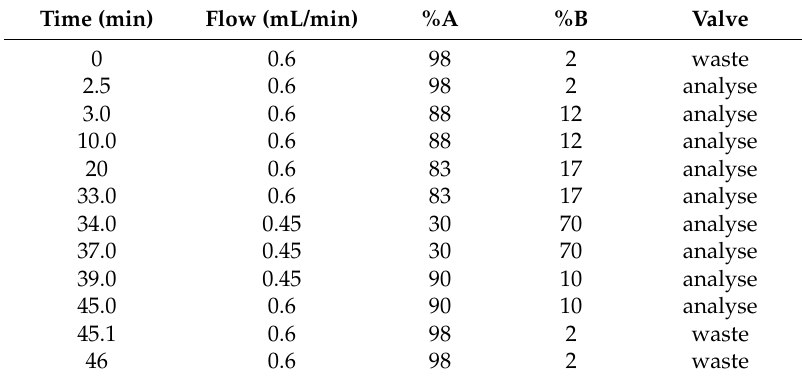
Table 5. Gradient for separation of HMO by hydrophilic interaction liquid chromatography with fluorescence detection